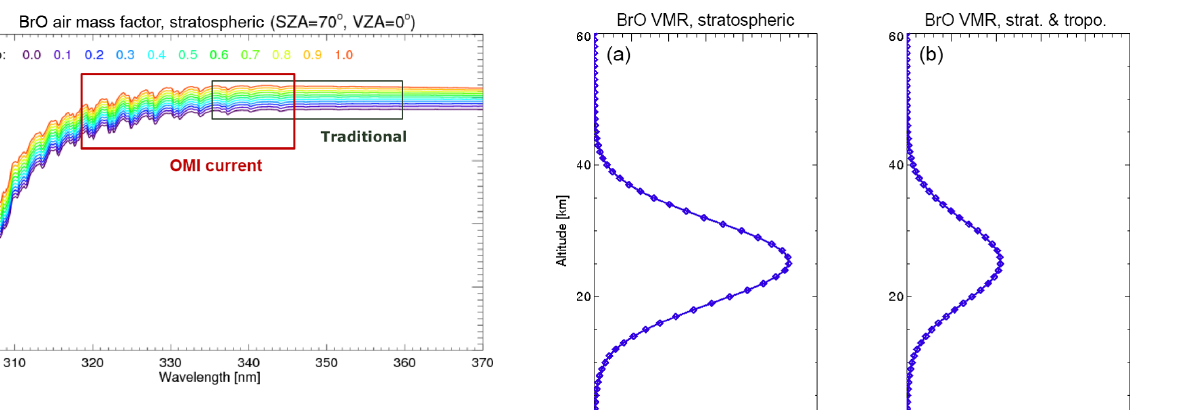
Figure 2. Wavelength- and albedo-dependent air mass factors cal- culated using a mostly stratospheric fixed BrO profile. The blue box shows the fitting window used in our previous versions, and the red box shows the fitting window used in the current operational algo- rithm.